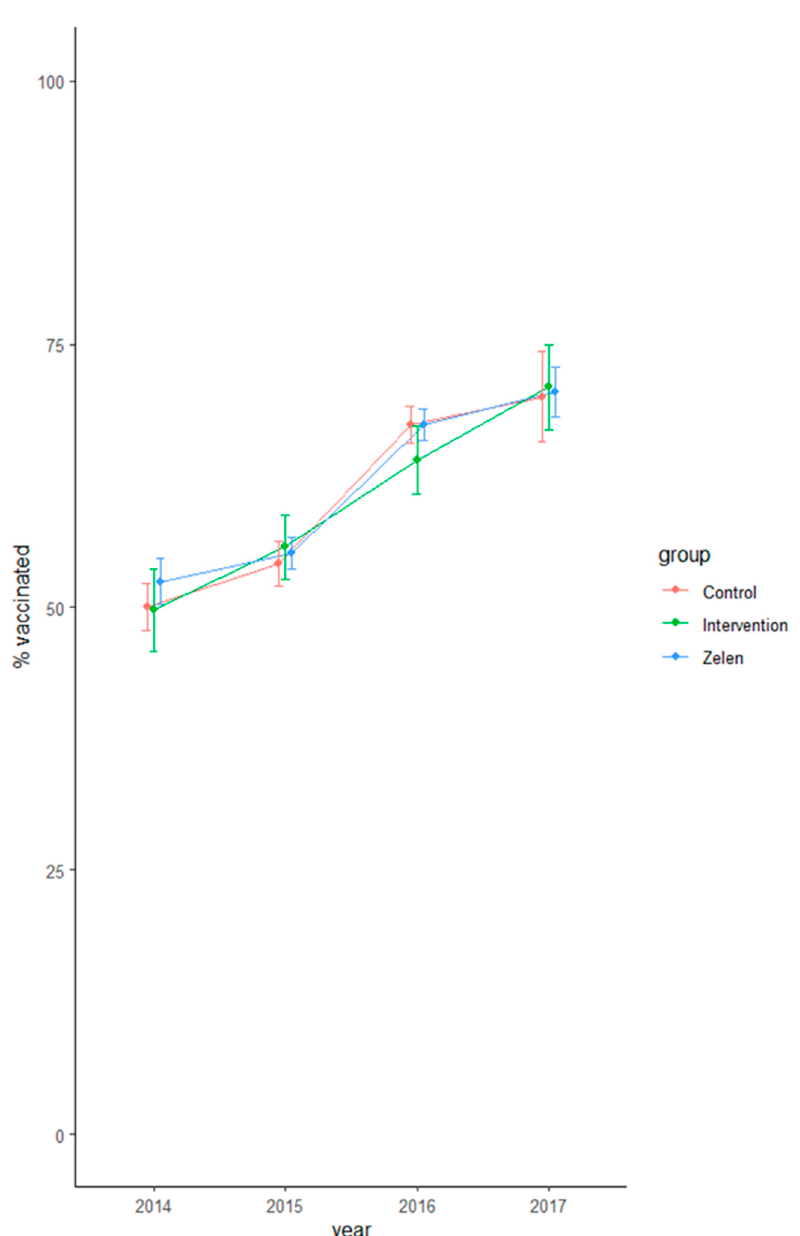
Figure 1. Vaccination uptake in the three groups. Legend: Estimate and 95% CI of the percent vaccinated per year and different study arms.